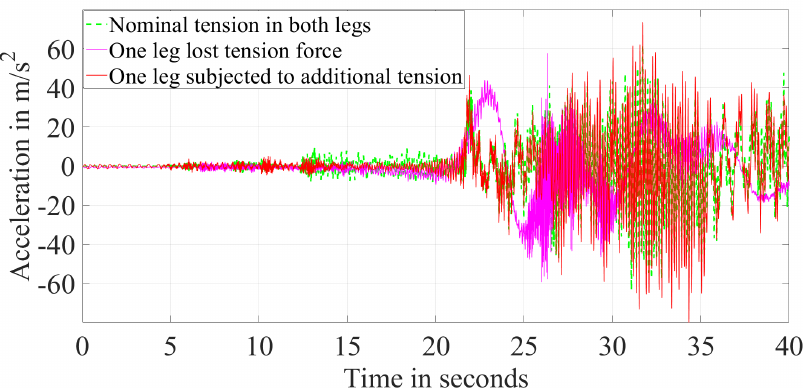
Figure 20. Comparison of maximum horizontal acceleration before and after fault